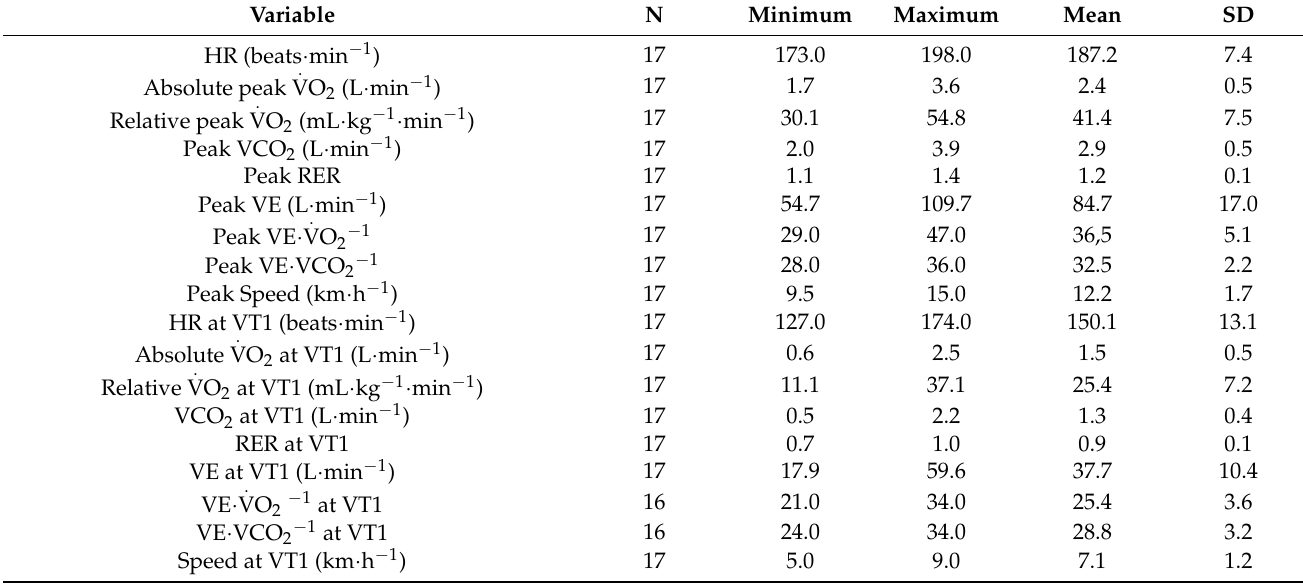
Table 1. Cardioventilatory data achieved during the incremental treadmill test.